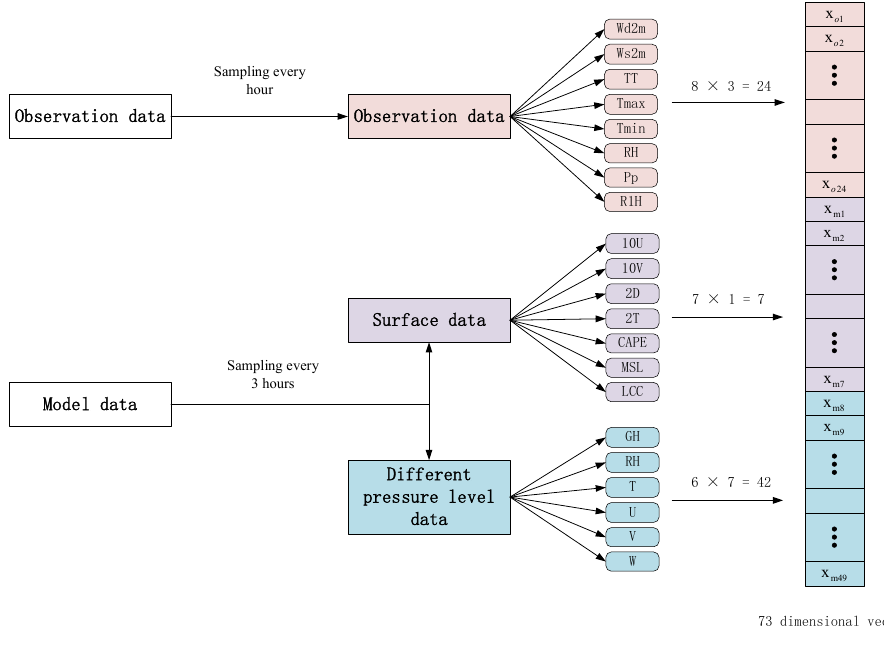
Figure 2. Schematic illustration of the sample construction process.